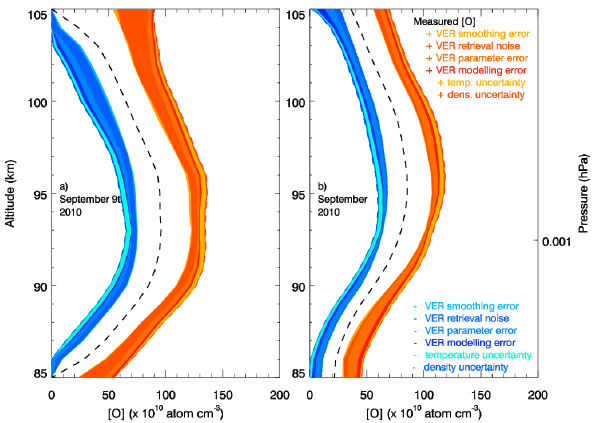
Figure 8. Sample daily (a) and monthly (b) averaged atomic oxygen concentration ([O quench ]) profiles for the 20–25 ◦ N latitude range SABER with uncertainty components σ S (yellow), σ S (light red), σ S s m b (orange), σ S (red) introduced for retrieving V ER + 1 and propa- f gated to [ O ] + 1 , while σ + (light yellow and dark orange marked TD components) is calculated directly for the determination of [ O ] + 1